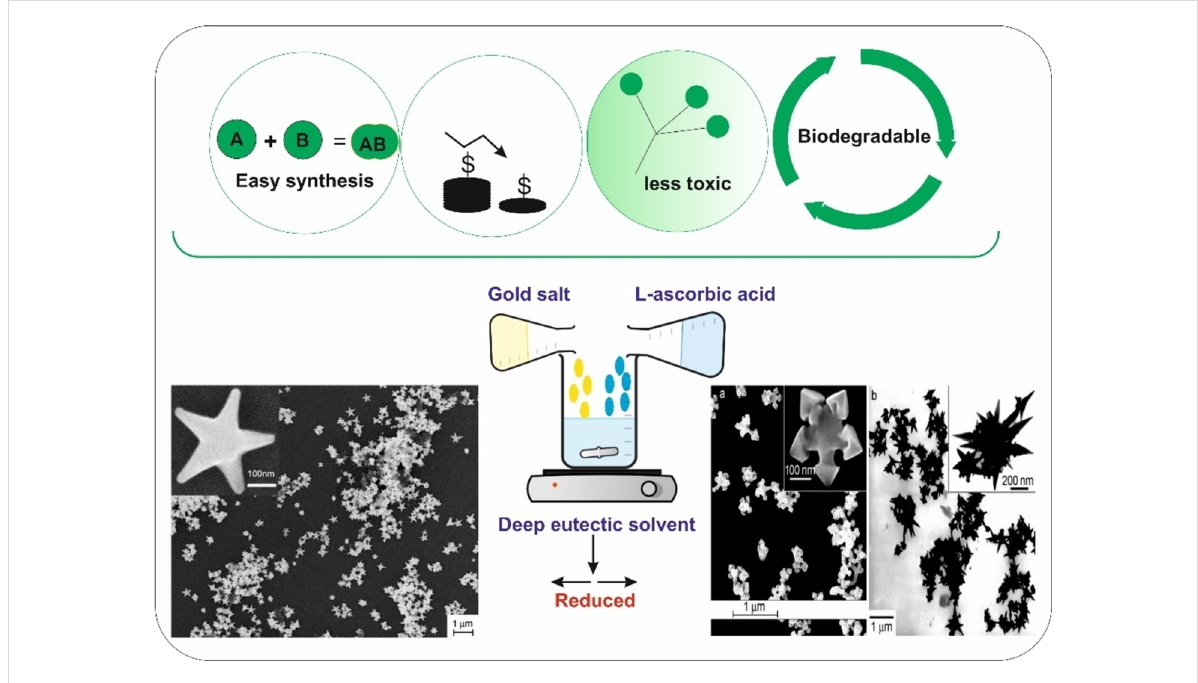
Figure 4: A deep eutectic solvent as green solvent in the synthesis of anisotropic nanoparticles (flower shape). All micrographs are adapted from [27], H. G. Liao et al., “Shape-Controlled Synthesis of Gold Nanoparticles in Deep Eutectic Solvents for Studies of Structure-Functionality Relationships in Electrocatalysis”, Angew. Chem. Int. Ed., with permission from John Wiley and Sons. Copyright © 2008 Wiley-VCH Verlag GmbH & Co. KGaA, Wein- heim. This content is not subject to CC BY